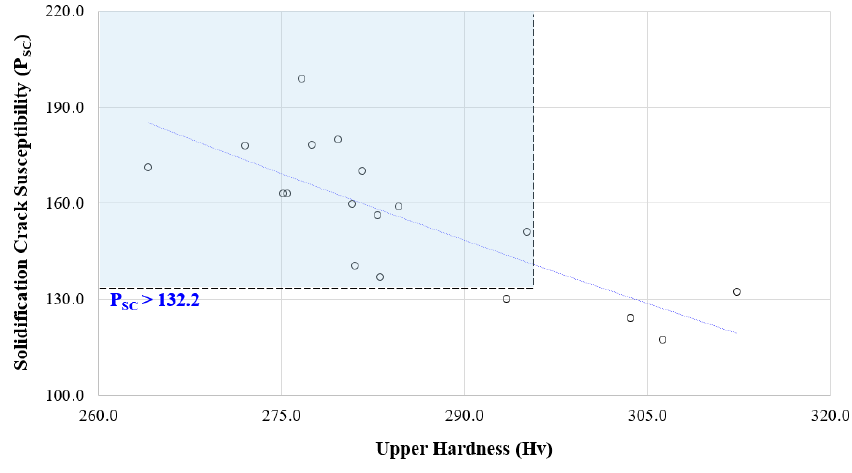
Figure 8. P SC distributions according to upper hardness in fiber laser welding.